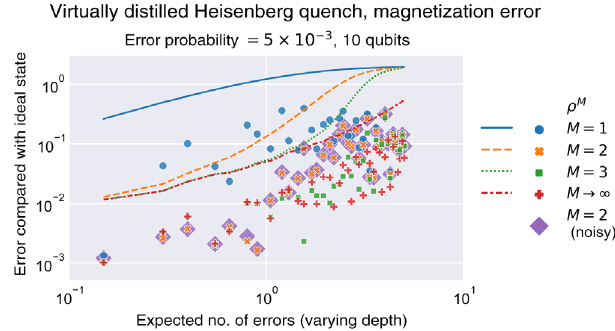
FIG. 7. The average error in the single-site magnetization in the unmitigated noisy states ( M ¼ 1 ), the states accessed by our error mitigation technique ( M ¼ 2 , 3), and the dominant eigenvectors of the density matrices ( M → ∞ ) for states generated by the Trotterized time evolution of a Heisenberg model. We plot the actual average errors we calculate using the blue dots ( M ¼ 1 ), orange crosses ( M ¼ 2 ), green squares ( M ¼ 3 ), red diamonds ( M → ∞ ), and large purple diamonds ( M ¼ 2 , noisy distillation) alongside bounds determined by the trace distance to the ideal state using Eq. (48) (various curves). We plot these quantities as a function of the expected number of single-qubit depolarizing errors, which we vary by varying the number of gates, fixing the single-qubit depolarizing probability to 5 × 10 − 3 . We see that for this specific observable, the trace distance bounds are pessimistic by roughly an order of magnitude, though they generally respect the behavior of the eigenvector floor. Furthermore, we notice an almost perfect coincidence between the orange crosses and purple diamonds, indicating that performing the virtual distillation circuits of Sec. II A with noise has a negligible effect on the corrected expectation